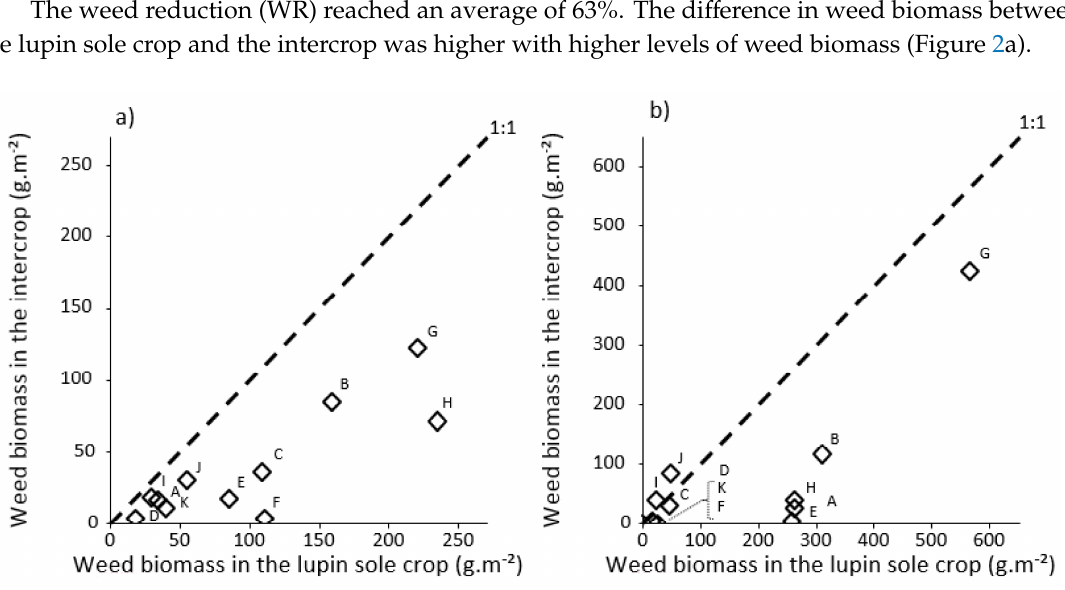
Table 4. Crop and weed biomass production and soil N acquisition at the 11 sites in lupin sole crops (SCs) and lupin–triticale intercrops (ICs) during two periods, from sowing to lupin flowering, and from lupin flowering to maturity.